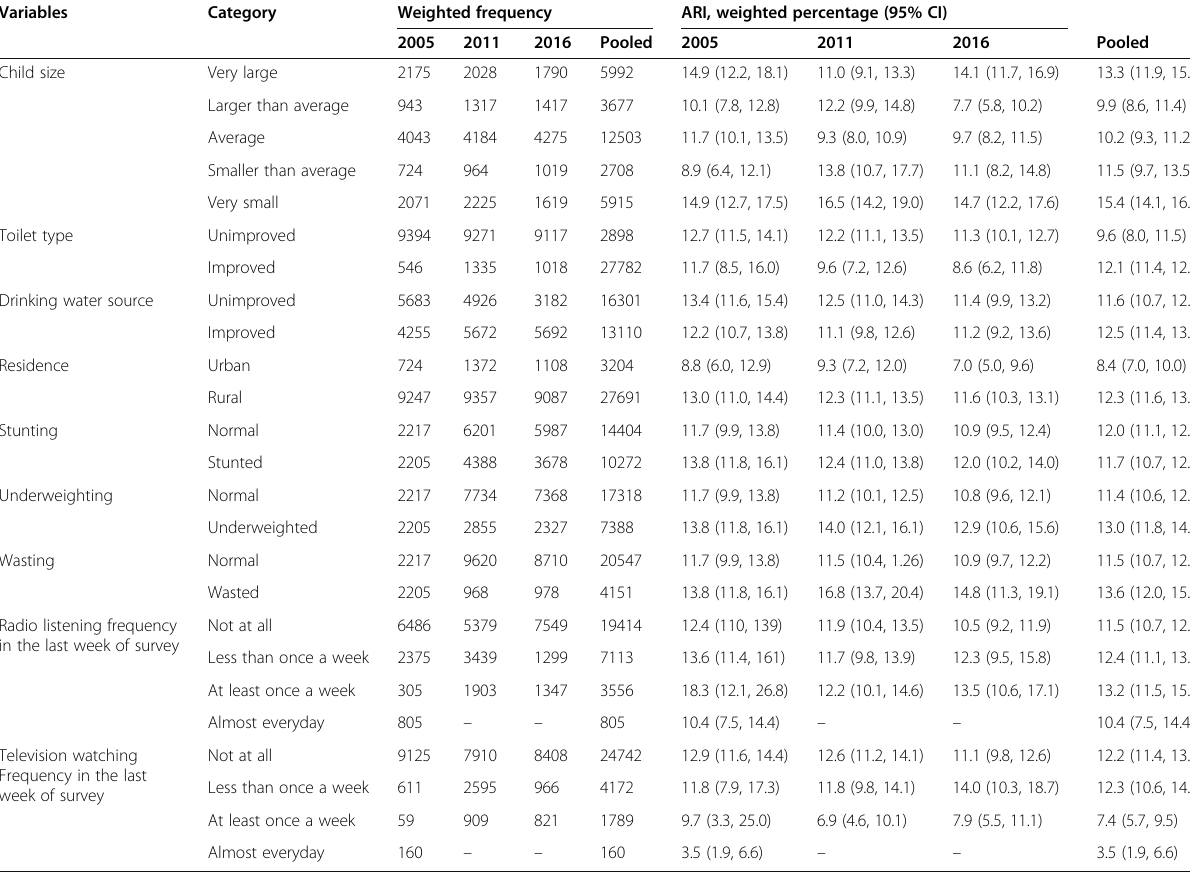
Table 2 Acute respiratory infection on under-five children across different variable selected, EDHS 2005 – 2016